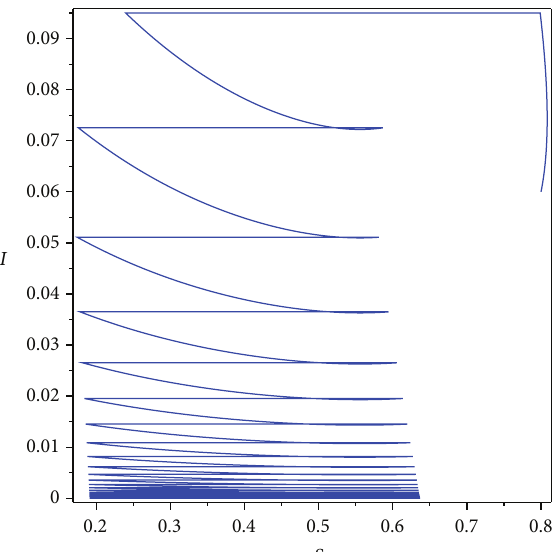
Figure 4: Phase diagram of system (42) while 𝜃 = 0 .